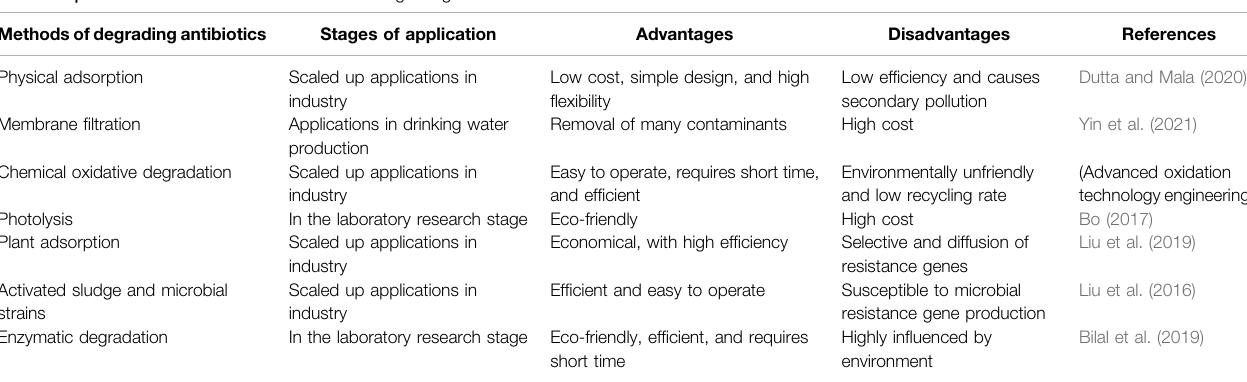
Frontiers in Environmental Science |